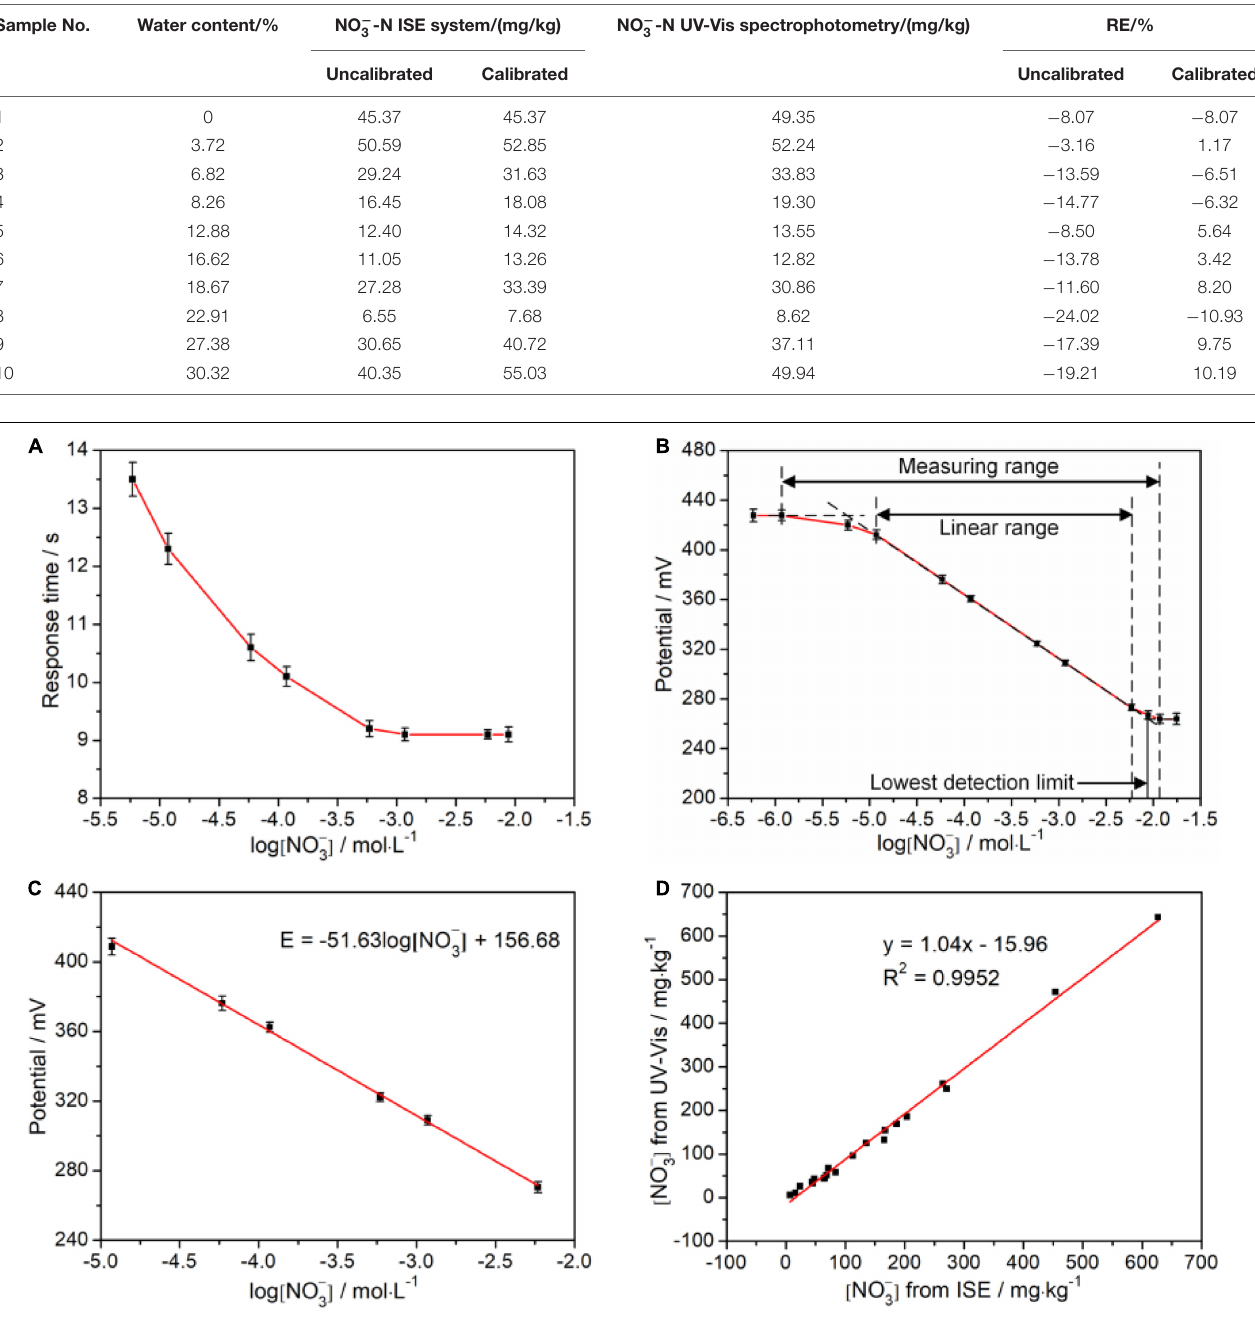
TABLE 1 | NO − 3 -N concentrations in soil with different soil water contents. Sample No.